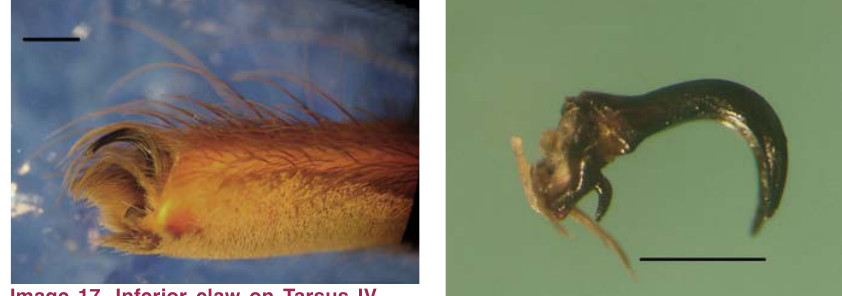
Image 17. Inferior claw on Tarsus IV. Scale 1